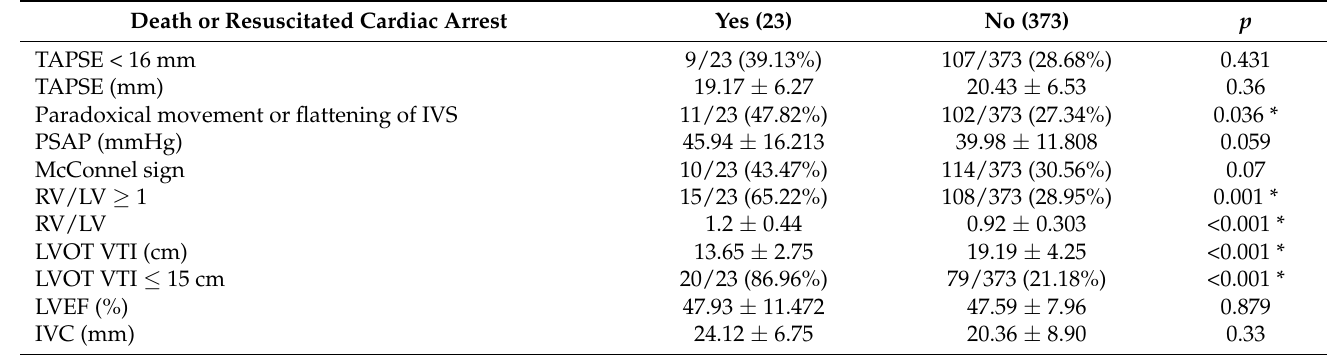
Table 4. Comparative baseline echocardiographic parameters in patients with and without in hospital death or resuscitated cardiac